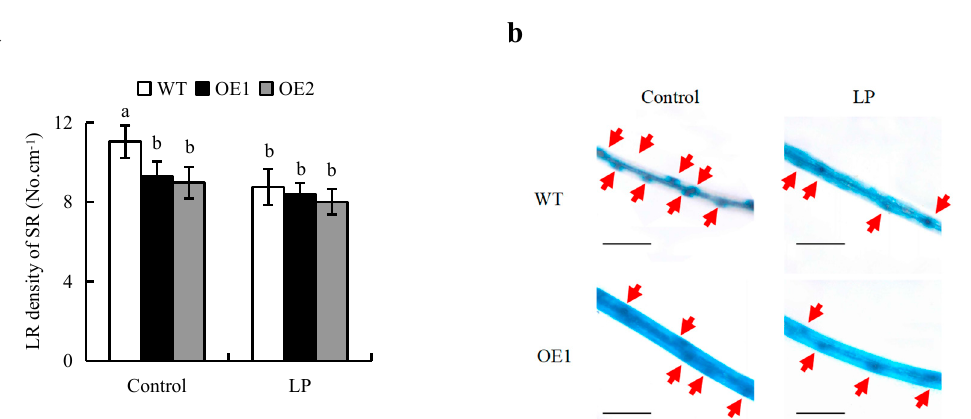
Figure 5. Lateral root (LR) density and lateral root (LR) primordia in wild type (WT, Nipponbare) and OsPIN2 overexpression lines (OE1/OE2). Seedlings were grown in hydroponic media containing normal nutrition (control, 300 μ M P) or low P (LP, 10 μ M). ( a ) LR density of SR. ( b ) Lateral root (LR) primordia formation. Bar = 1mm. Data are means ± SE and bars with different letters indicate significant differences in the same gene ( p < 0.05, ANOVA). The red arrow indicates the LR primordia. All experiments included three independent biological replicates.